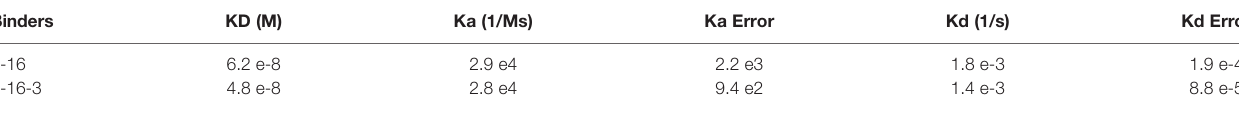
TABLE 3 | SPR of PD-L1 speci fi c VH domains 1-16 and 1-16 derived 1-16-3.